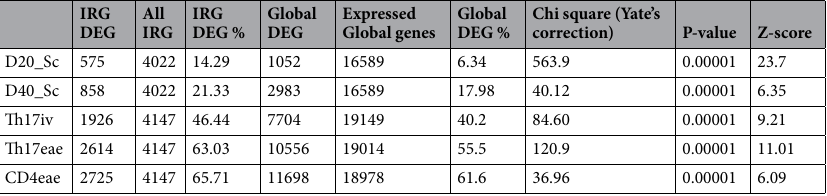
Table 1. Probability of IRG DEG enrichment in CNS and CD4 T lymphocytes during experimental neuroinflammation. DEG = differentially expressed gene; Sc = Spinal cord; eae = experimental autoimmune encephalomyelitis; Th17iv = in vitro differentiated T helper 17